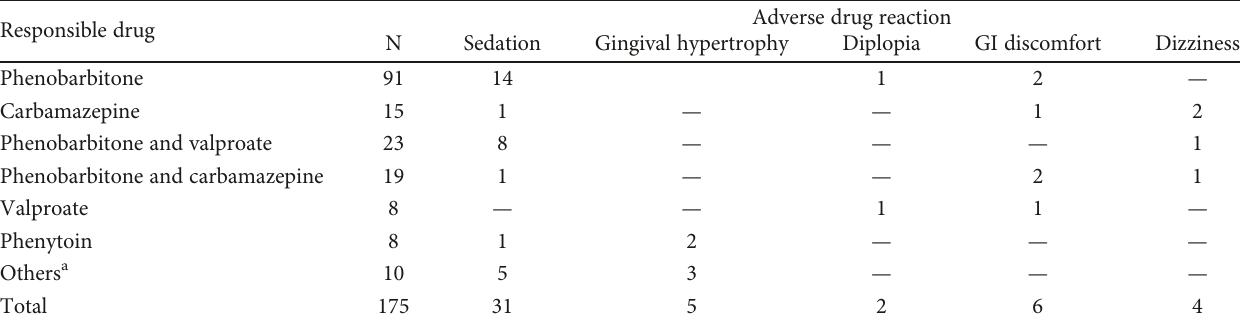
Table 7: Reported adverse drug events of